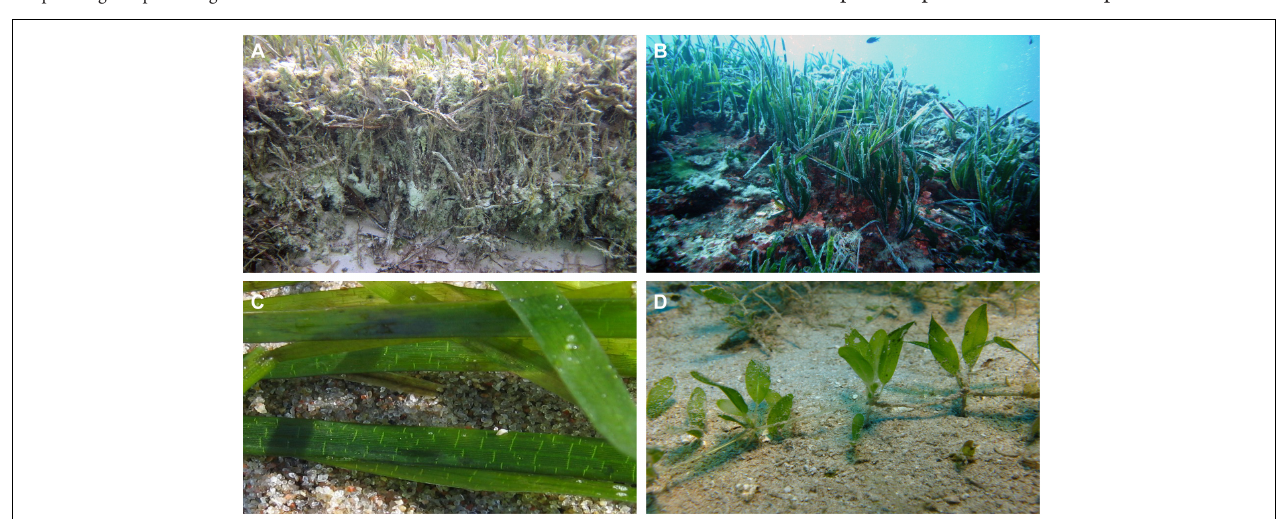
FIGURE 1 | Morphological diversity of selected species of seagrasses. (A) Thalassia testudinum (turtle grass) bed with view of jointed rhizomes, San Salvador Island, Bahamas. (B) Posidonia oceanica (Neptune grass) meadow with view of rhizome matts, Portofino, Italy. (C) Zostera marina (eelgrass) with ribbon-like blades. (D) Halophila decipiens (paddle grass) with paddle-shaped blades. (https://commons.wikimedia.org and https://calphotos.berkeley.edu/).